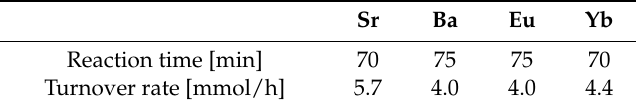
Table 2. Reaction times and turnover rates for the reaction of Sr, Ba, Eu and Yb with SF 6 .